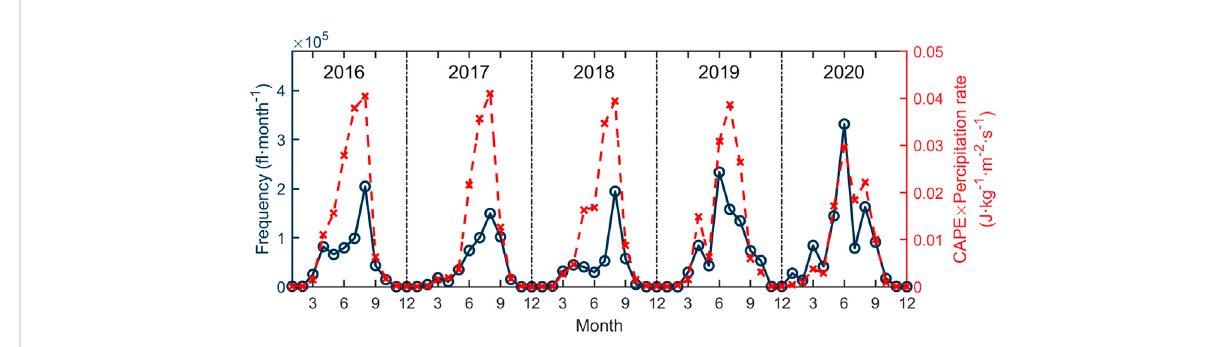
FIGURE 11 The monthly temporal distribution of the lightning frequency (y-axis on the left) and CAPE×P (y-axis on the right) on the Yungui Plateau from 2016 to 2020.